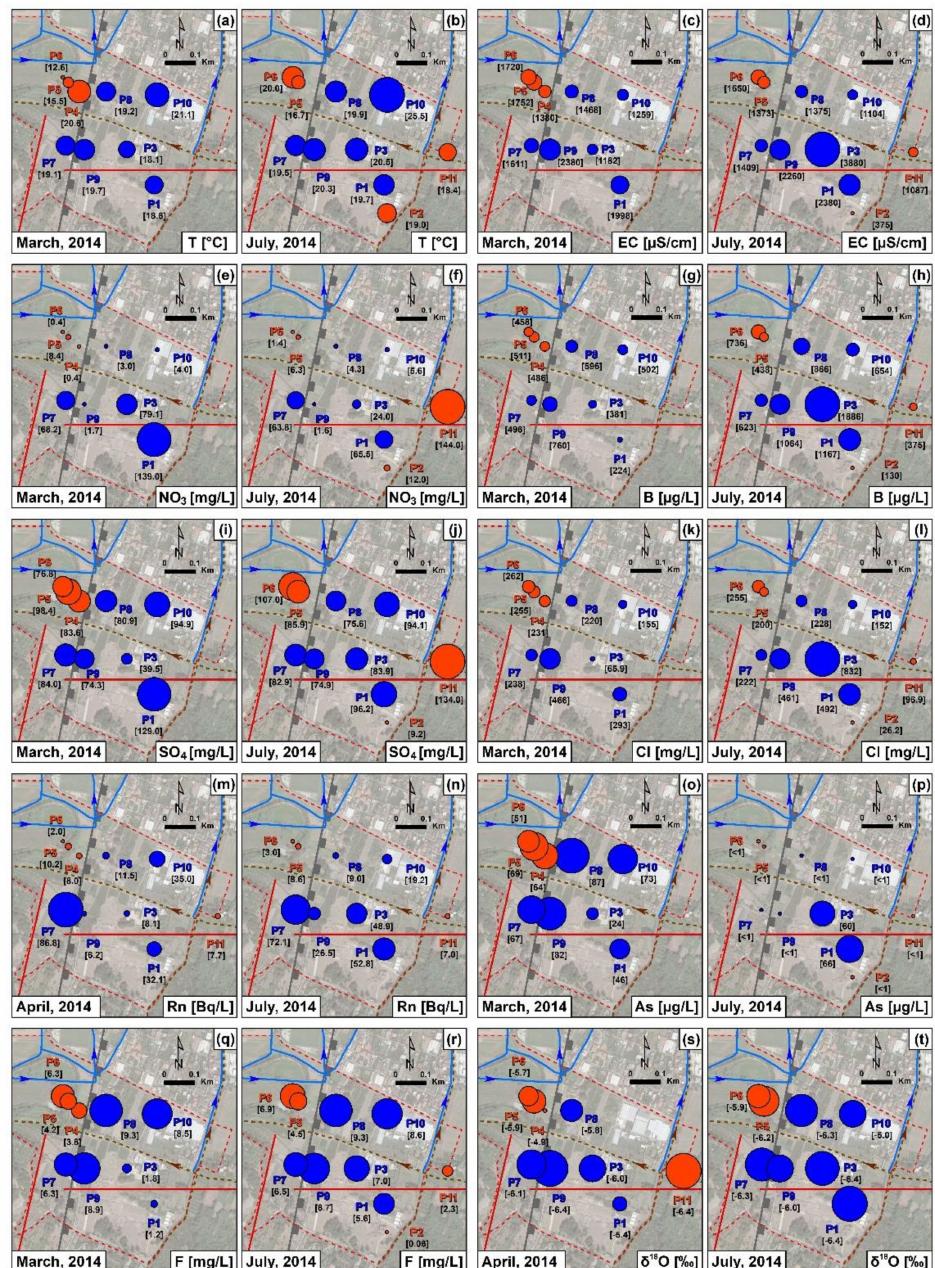
Figure 6. Bubble maps of values of physico-chemical parameters (T ( a ) and ( b ) and -EC ( c ) and ( d )), concentrations of major ions and trace elements (NO 3 − ( e ) and ( f ), Boron ( g ) and ( h ), SO 42 − ( i ) and ( j ), Cl − ( k ) and ( l ), F − ( q ) and ( r ) and Arsenic ( o ) and ( p )) and isotopes ( 222 Rn ( m ) and ( n ) and δ 18 O ( s ) and ( t )) in Rc and Rs periods for the shallow (in red) and deep (in blue) wells. Radius of bubbles is proportional to the value of each